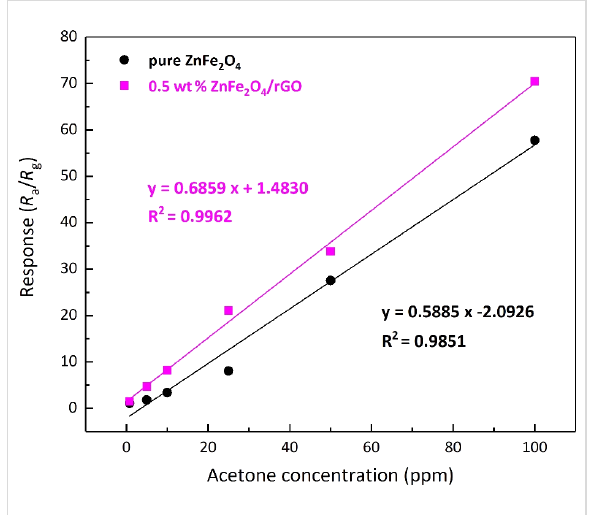
Figure 9: Linear response of (a) the hollow spheres of pure ZnFe 2 O 4 and (b) of ZnFe 2 O 4 /rGO with 0.5 wt % rGO to acetone at different con-